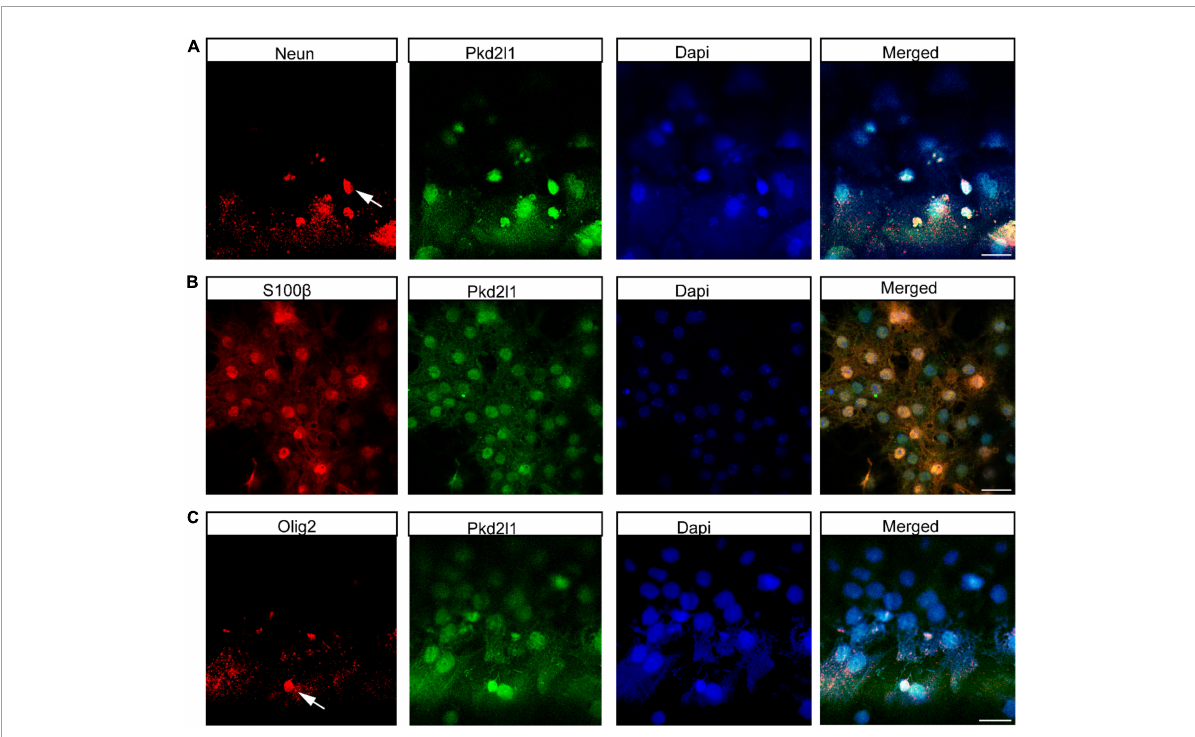
FIGURE3 Cerebrospinal fluid-contacting neurons (CSF-cNs) have tripotential differentiation capacity in vitro . (A) Immunofluorescence analysis showed that CSF-cNs differentiated into NeuN-expressing neurons. (B) Immunofluorescence analysis displayed that CSF-cNs differentiated into S100 β -expressing astrocytes. (C) Immunofluorescence analysis showed that CSF-cNs differentiated into Olig2-expressing oligodendrocytes. Scale bar represents 50 µ m in panels (A–C)